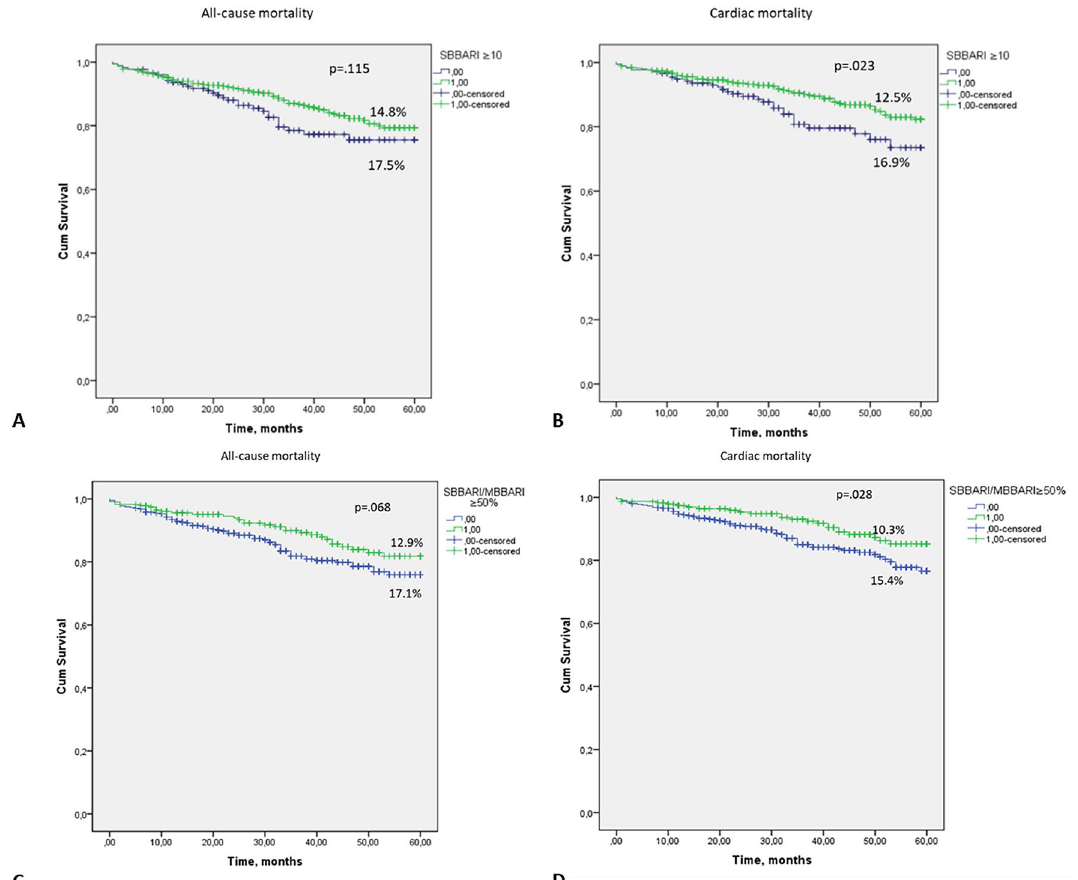
Figure 4. Kaplan–Meier curves: ( A ) All-cause mortality in patients with SBBARI score ≥ 10% and < 10%. ( B ) Cardiac mortality in patients with SBBARI score ≥ 10% and < 10%. ( C ) All-cause mortality in patients with SBBARI/MBBARI ≥ 50% and less < 50%; ( D ) Cardiac mortality in patients with SBBARI/MBBARI ≥ 50% and less <